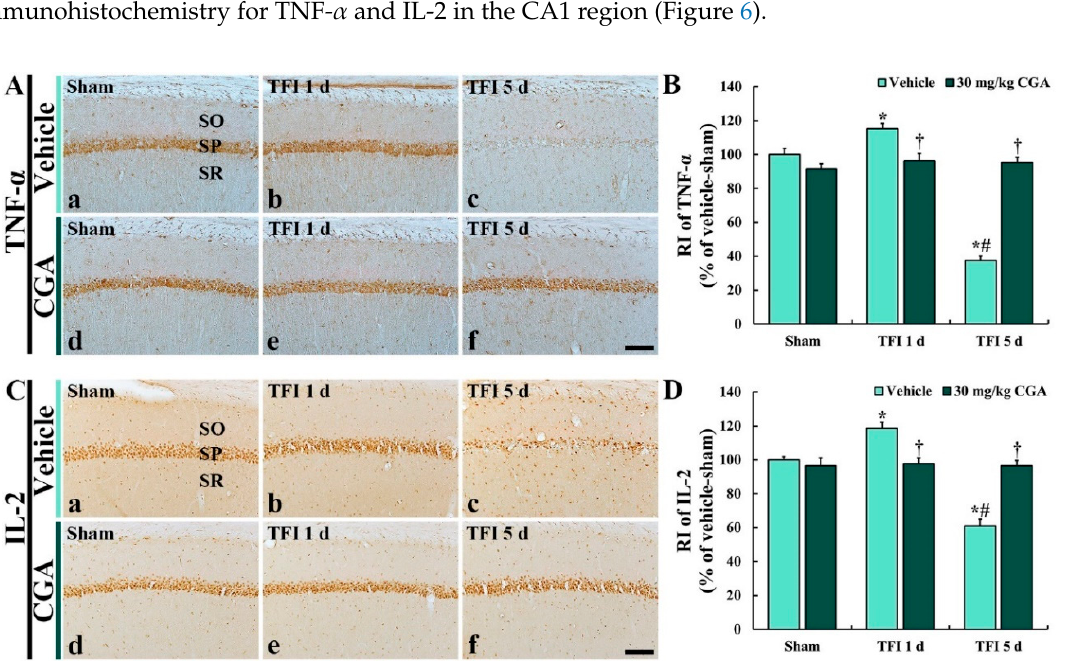
Figure 6. Immunohistochemistry for TNF- α ( A ) and IL-2 ( B ) of the vehicle/sham ( A ( a ), C ( a )), CGA/sham ( A ( d ), C ( d )), vehicle/TFI ( A ( b , c ), C ( c , d )) and CGA/TFI ( A ( e , f ), C ( e , f )) groups at 1 and 5 days after TFI. TNF- α and IL-2 immunoreactivities are basically detected in the CA1 pyramidal cells of the vehicle/sham group. However, TNF- α and IL-2 immunoreactivities in the vehicle/TFI group are dramatically altered after TFI. In the CGA/sham group, TNF- α and IL-2 immunoreactivities are similar to those in the sham groups, and these immunoreactivities are maintained after TFI. Scale bar = 40 μ m, C and D: RI of TNF- α ( C ) and IL-2 ( D ), respectively, in theCA1 SP. The bars indicate the means ± SEM ( n = 7 at each point in time, * p < 0.05 vs. the vehicle/sham group, † p < 0.05 vs. the corresponding time point vehicle group, # p < 0.05 vs. the pretime point vehicle group).